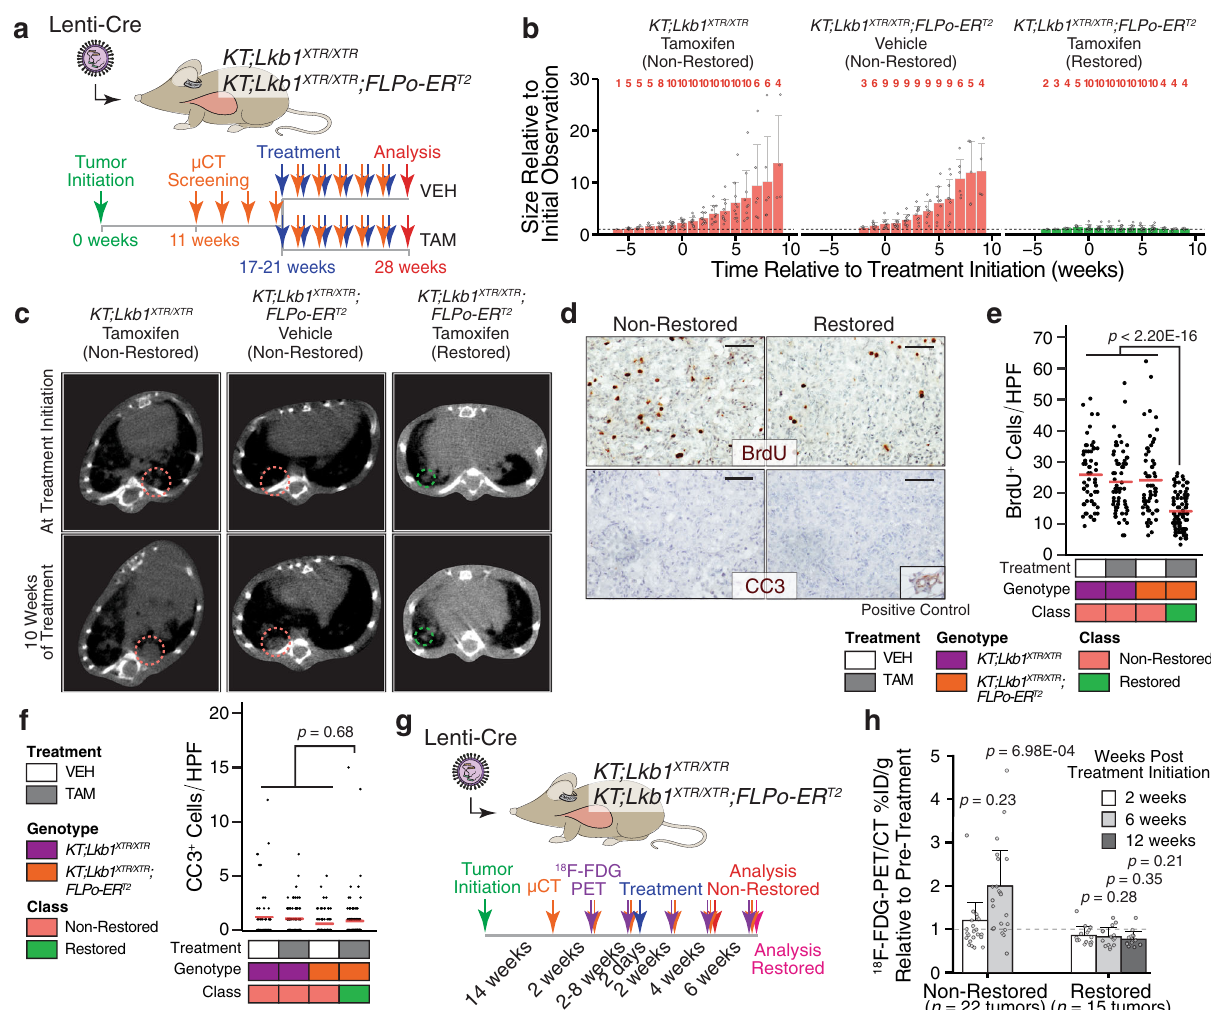
Fig. 2 Lkb1 restoration drives tumor stasis and suppresses the increase in glucose avidity that accompanies progression. a Longitudinal µ CT imaging of lung tumors in KT;Lkb1 XTR/XTR and KT;Lkb1 XTR/XTR ;FLPo-ER T2 mice. Treatment began within 1 to 6 weeks from initial detection of lung tumors. Tumors were tracked for an additional 6 – 10 weeks, and lung tissue was harvested at 28 weeks. VEH vehicle, TAM tamoxifen. b Changes in tumor volume. Red numbers indicate the number of tumors measured at a given time point. Bars correspond to the mean tumor volume relative to size at fi rst detection. Error bars indicate standard deviation. Source data is displayed in Supplementary Fig. 6b. KT;Lkb1 XTR/XTR -tamoxifen, n = 10 tumors; KT;Lkb1 XTR/XTR ;FLPo-ER T2 -vehicle, n = 9 tumors; KT;Lkb1 XTR/XTR ;FLPo-ER T2 -tamoxifen, n = 10 tumors. c Representative µ CT images of tumor-bearing lungs at treatment initiation (top) and after 10 weeks of treatment (bottom). d BrdU (top) and cleaved caspase 3 (CC3; bottom) detection by IHC within Lkb1 non-restored (left) and restored (right) lung tumors following 2 weeks of treatment with vehicle or tamoxifen. Inset image shows CC3 staining of involuting mammary gland. Scale bars = 100 µ m. Images were acquired from a single experiment including multiple biological replicates as noted in e , f . e , f Quanti fi cation of BrdU + ( e ) and CC3 + ( f ) cells within Lkb1 -restored and non-restored tumors. Each dot represents a ×20 fi eld. Red crossbars indicate the mean. In e , KT;Lkb1 XTR/XTR - vehicle, n = 60 fi elds; KT;Lkb1 XTR/XTR -tamoxifen, n = 60 fi elds; KT;Lkb1 XTR/XTR ;FLPo-ER T2 -vehicle, n = 60 fi elds; KT;Lkb1 XTR/XTR ;FLPo-ER T2 -tamoxifen, n = 80 fi elds. In f , KT;Lkb1 XTR/XTR -vehicle, n = 60 fi elds; KT;Lkb1 XTR/XTR -tamoxifen, n = 80 fi elds; KT;Lkb1 XTR/XTR ;FLPo-ER T2 -vehicle, n = 80 fi elds; KT;Lkb1 XTR/ XTR ;FLPo-ER T2 -tamoxifen, n = 120 fi elds. One tissue section per mouse was analyzed. P values calculated by two-sided unpaired t test. HPF high-power fi eld, VEH vehicle, TAM tamoxifen. g Serial 18 F-FDG-PET/CT imaging. Tamoxifen treatment of KT;Lkb1 XTR/XTR , and KT;Lkb1 XTR/XTR ;FLPo-ER T2 mice began within 2 days of establishing baseline levels of 18 F-FDG uptake (at least two measurements within 18 – 24 weeks after tumor initiation). 18 F-FDG uptake was captured after 2 and 6 weeks of treatment, as well as at 12 weeks for restored mice. h Changes in 18 F-FDG uptake in restored ( n = 15 tumors) and non- restored ( n = 22 tumors) tumors. Source data displayed in Supplementary Fig. 8c. P values calculated by two-sided unpaired t